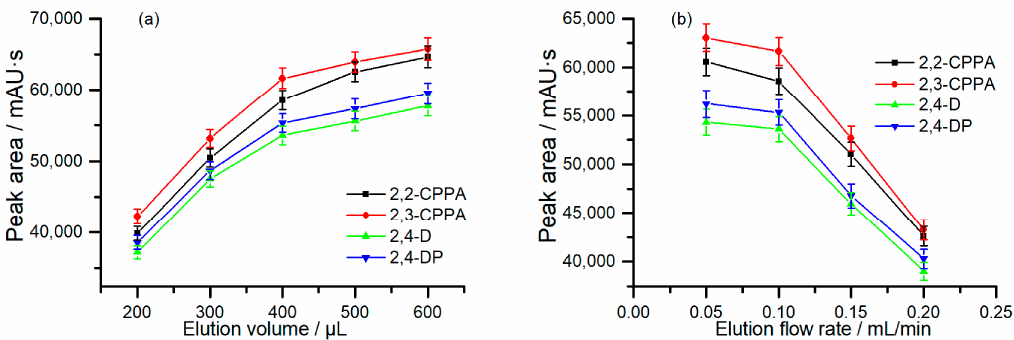
Figure 5. ( a ) Effect of elution volume on the extraction efficiencies of the analytes; ( b ) effect of elution flow rate on the extraction efficiencies of the analytes.